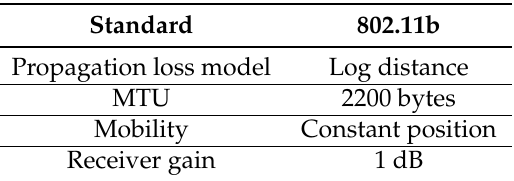
Table 2. Wireless fidelity (Wi-Fi) Parameters.